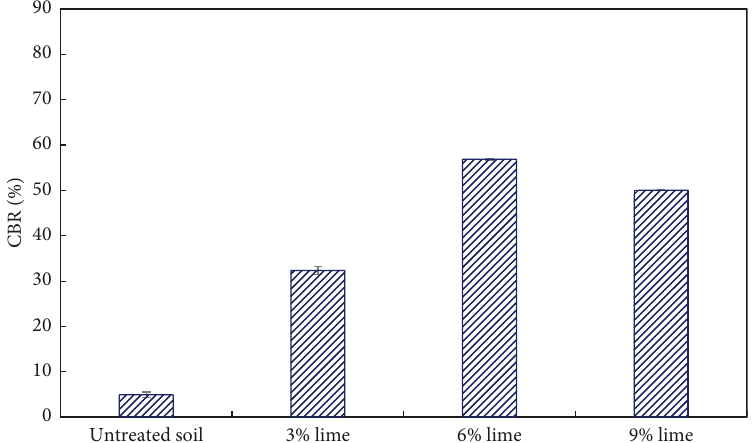
Figure 8: Effect of lime on the CBR of soil after 7days of treatment.